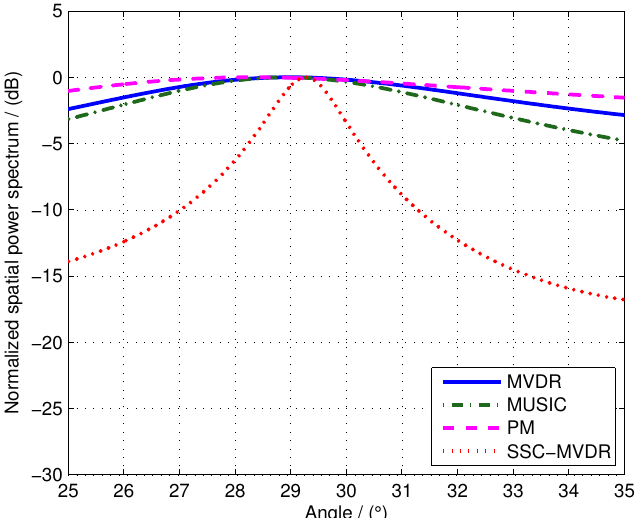
Figure 3. Normalized spatial power spectrums obtained by the MVDR method, the MUSIC method, the PM method and the SSC-MVDR method when the acoustic source intensity is − 10 dB and the snapshot number is 30.